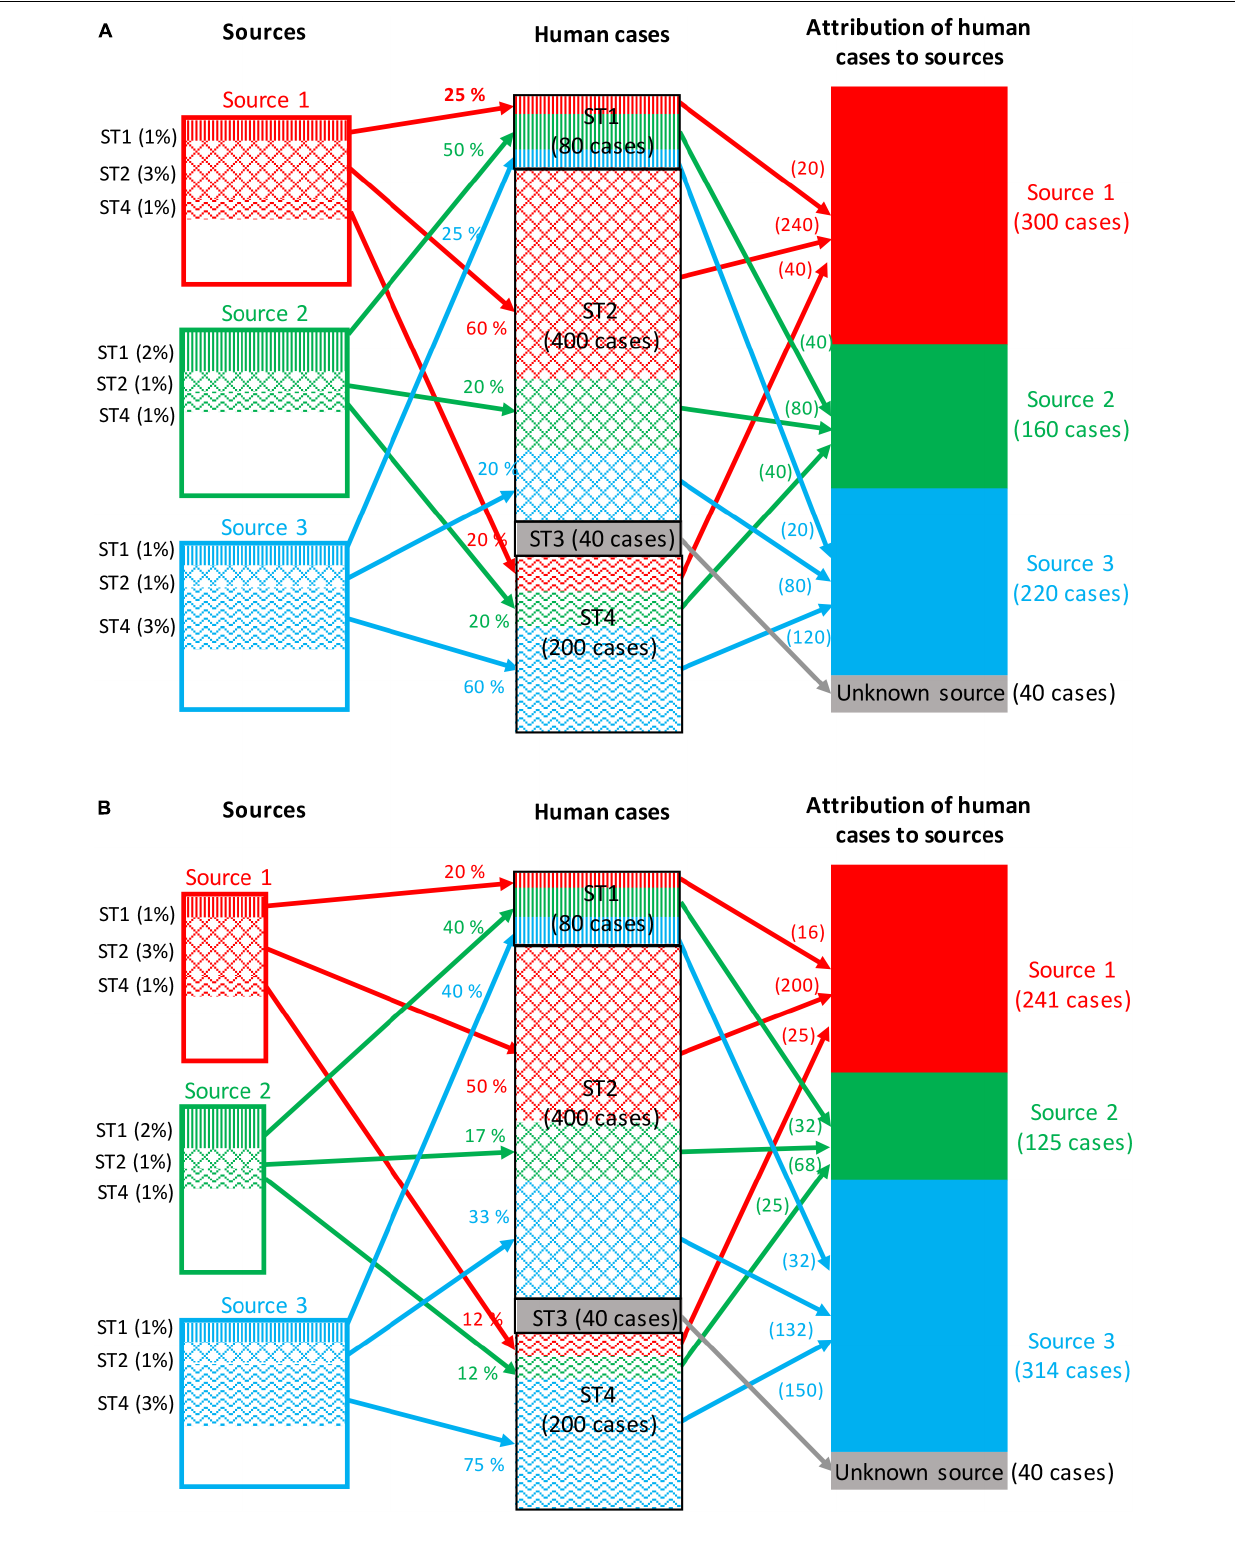
FIGURE 2 | Example of attribution of human cases (720 cases) of a given foodborne disease to three potential sources based on four microbial subtypes. (A) The attribution takes into account only the prevalence of all subtypes in each source, and the exposure to each source is then assumed to be constant. (B) The attribution takes into account both the prevalence and the exposure to each